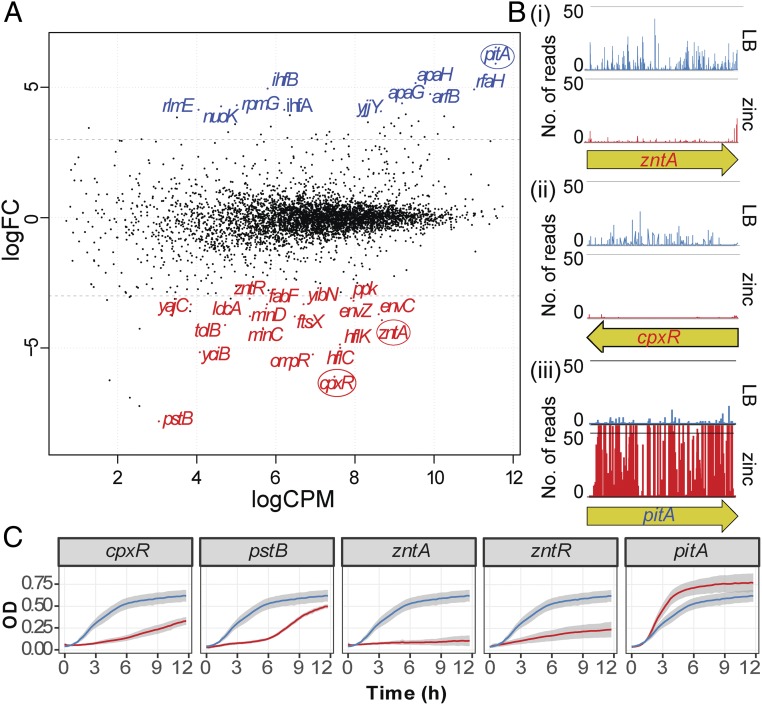
Identification and characterization of UPEC genes that influence growth in the presence of zinc. (A) Identification by TraDIS analysis of EC958 genes that regulate growth in 1 mM ZnSO4. Genes required for growth in zinc [logFC < −3 and false-discovery rate (FDR) < 0.001] are shown in red. Genes that, when mutated, promote growth in zinc (logFC > 4 and FDR < 0.001) are shown in blue. (B) Examples of reads mapped to individual insertion sites and their differences between control (LB) and test (LB-Zn) conditions for the zntA (i), cpxR (ii), and pitA (iii) genes. (C) Growth kinetics of wild-type (blue line) versus mutants (red line: ∆cpxR, ∆pstB, ∆zntA, ∆zntR, and ∆pitA) in LB-Zn conditions. Data (n = 3) are combined from three experiments, presented as mean (solid line) ± SEM (gray shades).